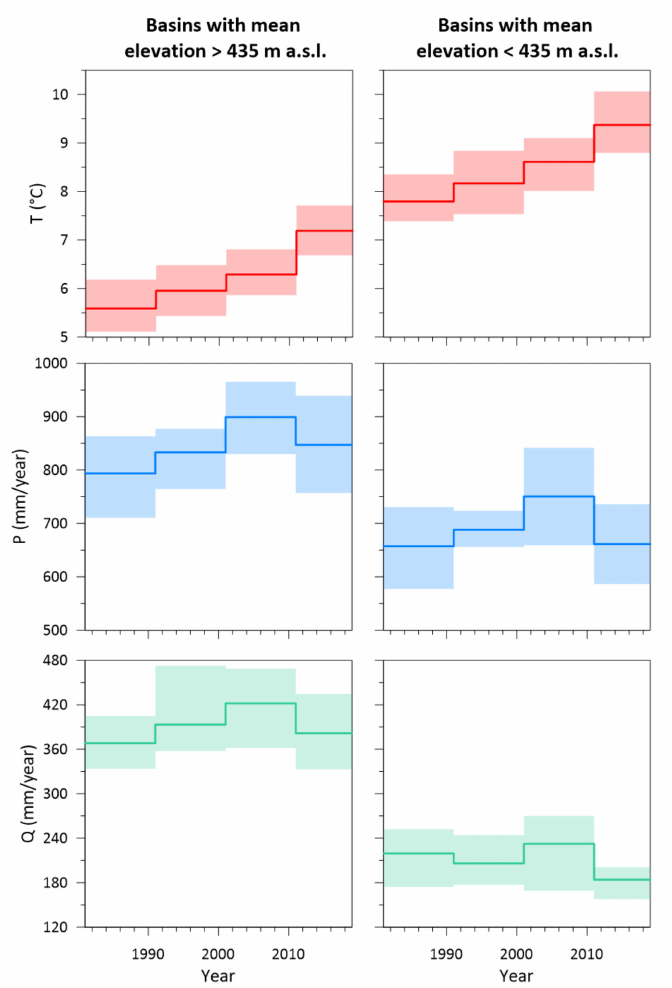
Figure 2. Changes in the hydroclimatic characteristics (long-term mean annual precipitation, air temperature, and runoff) over four decades. A line represents the medians of these characteristics for each of the four periods (i.e., 1981–1990, 1991–2000, 2001–2010, and 2011–2019) and for the two groups of the basins. The scatter (i.e., the 75 and 25% percentiles) indicates the variability between the